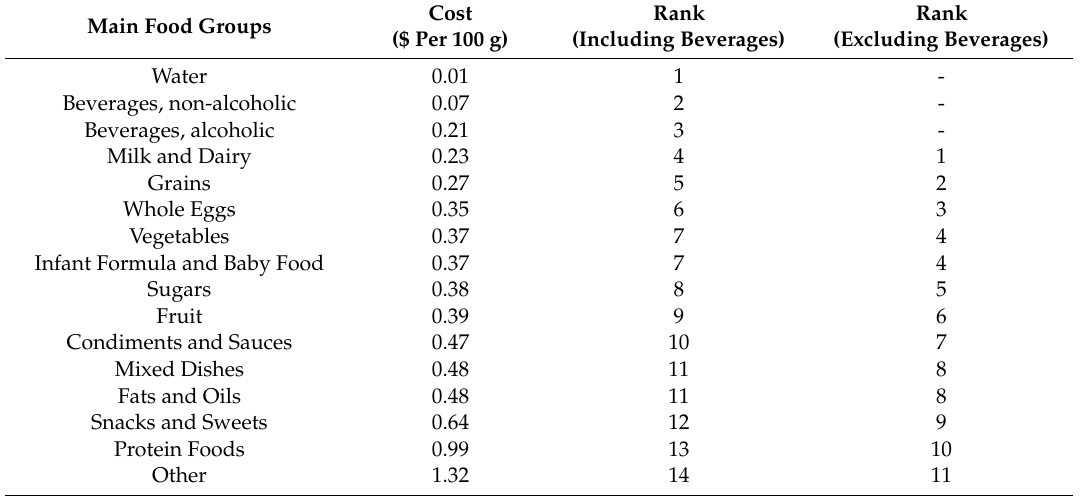
Table 1. Mean cost ($) and cost-e ffi cient ranking of USDA main food groups per 100 g compared to a whole egg.